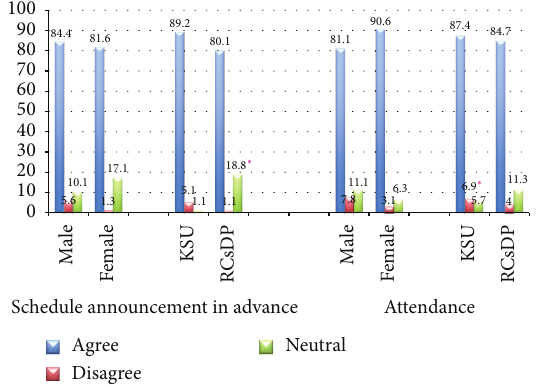
Figure 4: Percentage of dental students’ preferences regarding schedule announcements and attendance ( ∗ 𝑃 < 0.05 ).